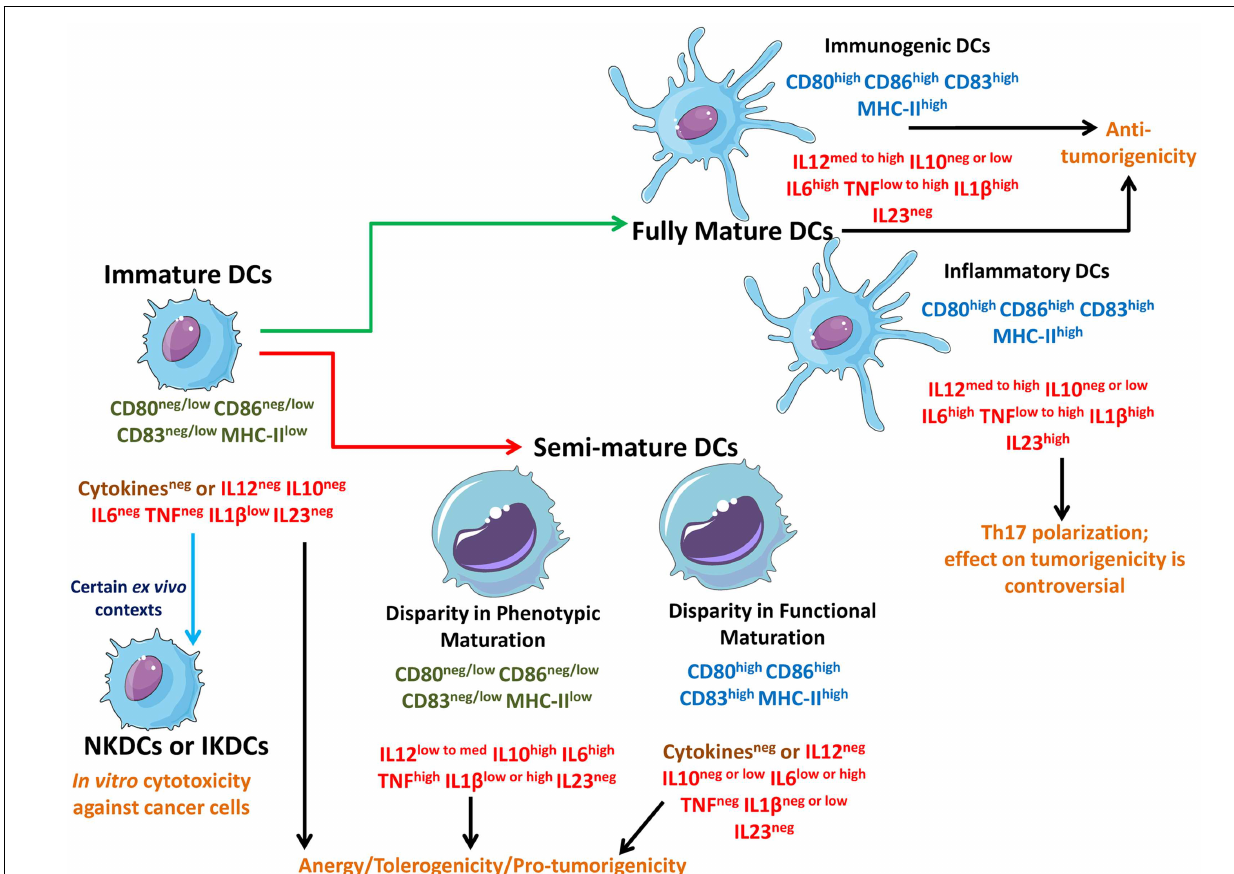
DCs and semi-mature DCs causeT cell anergy and facilitate tolerogenicity thereby compromising anticancer immunity.These DCs may also